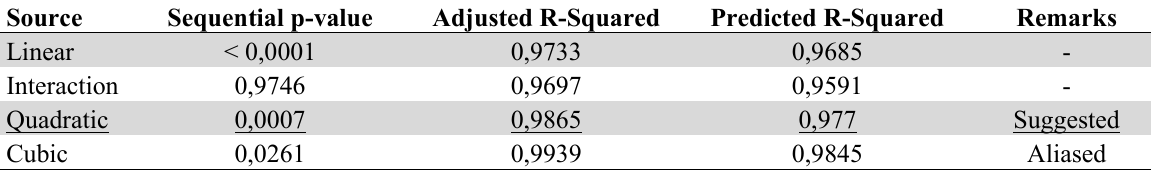
Fit Summary of surface roughness Ra using Coated inserts